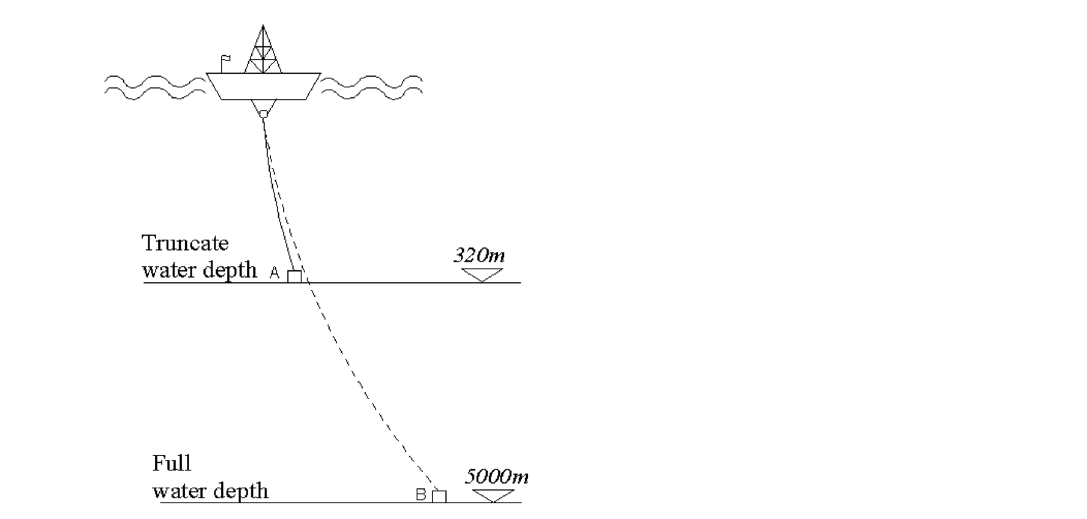
Figure 1. The truncated model of the testing system. Figure was created using AutoCAD 2020 software (URL: https:// www. autod esk. com. cn/), and this image was drawn by the co-author QingHui